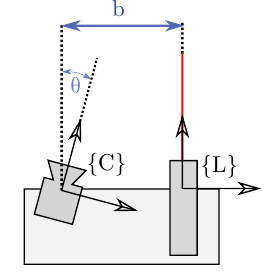
Figure 8: Standard laser scanner